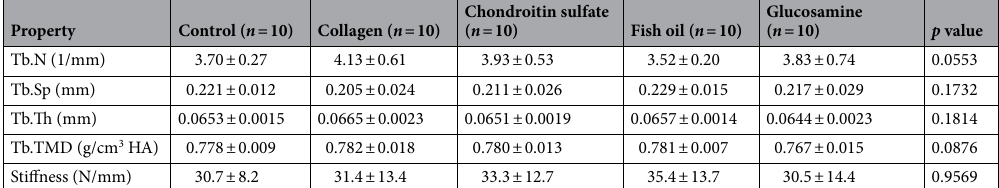
Table 4. Structural and mechanical properties of the vertebrae. Asterisks indicate a significant difference when compared to control. All values are reported as average ± standard deviation. Overall ordinary one way ANOVA or Kruskal Wallis p values are